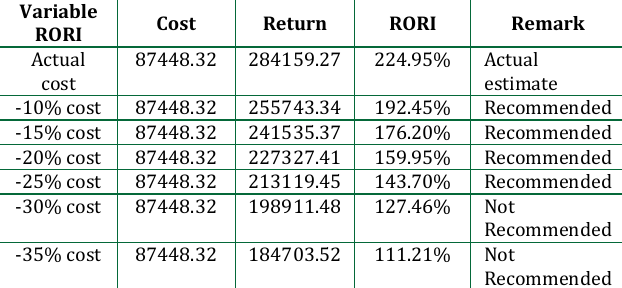
Table 10: Sensitivity analysis of Rate of Return on Investment of bio- fortified cassava (Decreasing revenue) Variable